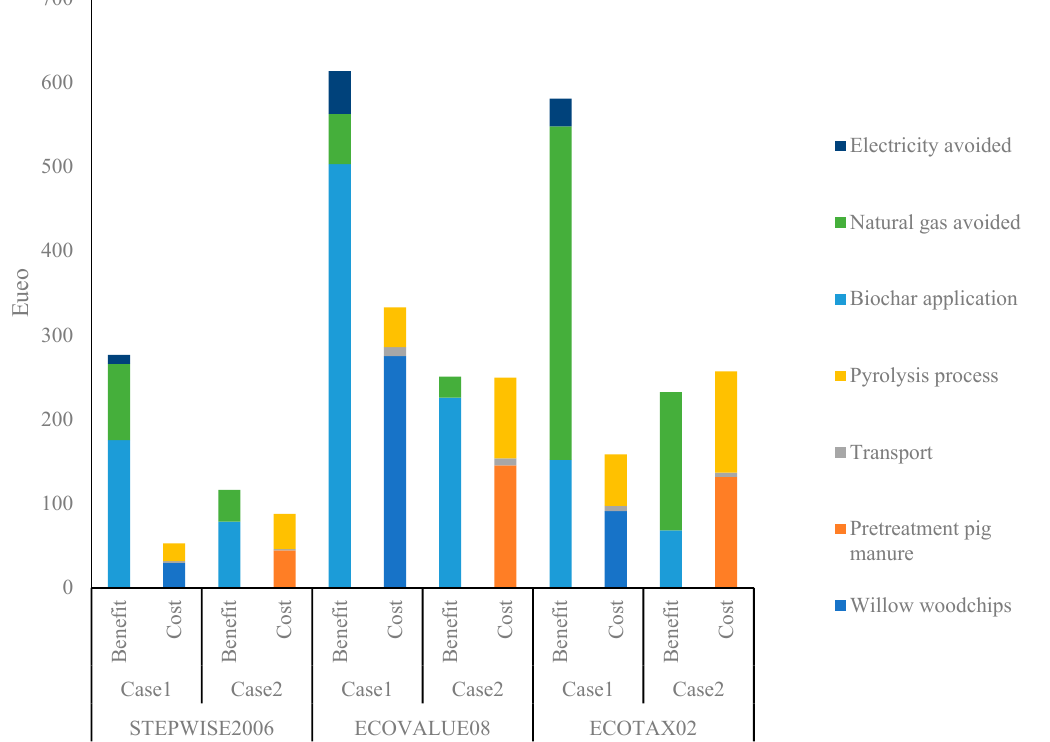
Figure 4. Environmental benefits and costs of two biochar production systems.